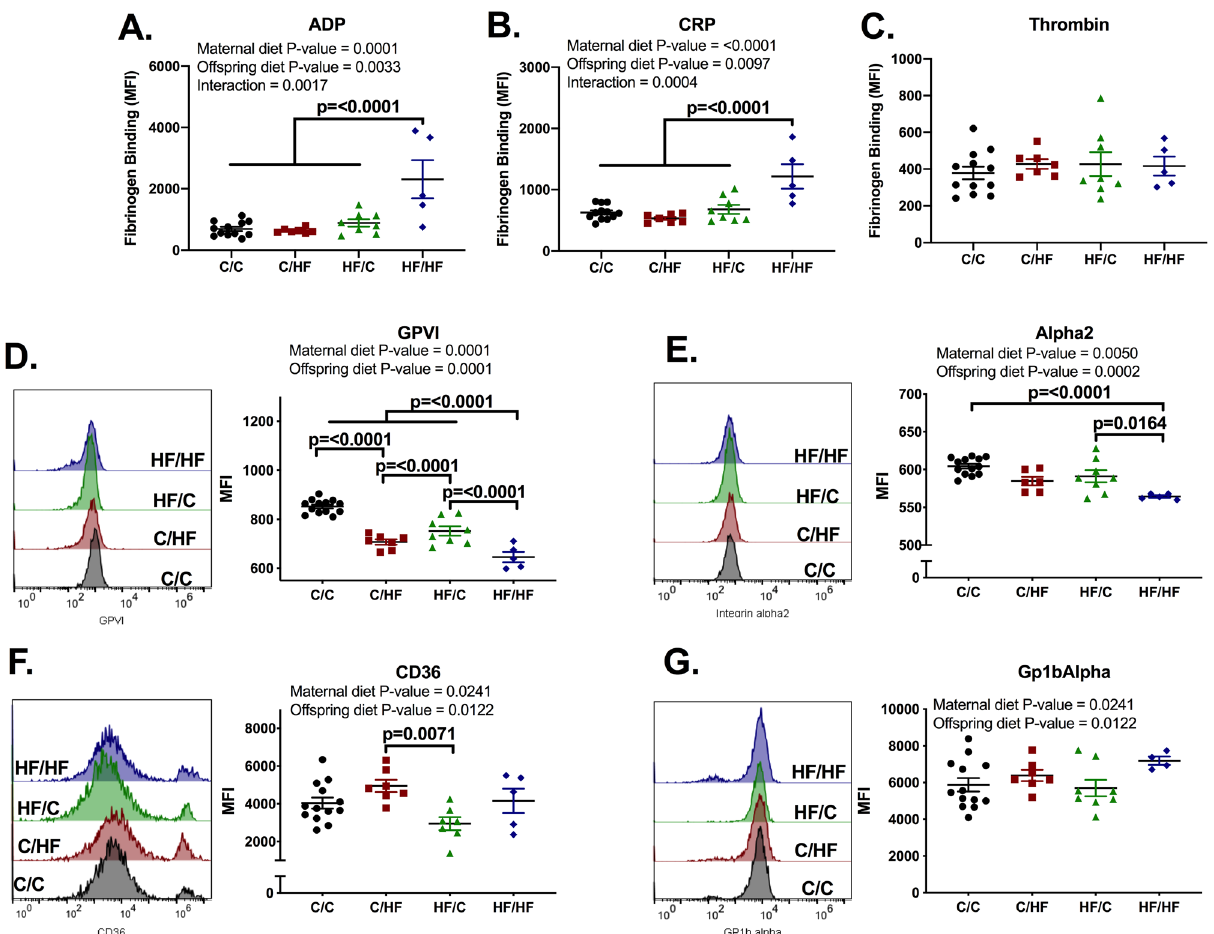
Figure 4. Maternal and offspring high-fat diet ingestion resulted in platelet hyperactivation of male offspring. Platelet-rich plasma (PRP) was stimulated with 10 μM ADP ( A ), 3 μg/mL CRP ( B ) or 0.1 U/mL Thrombin ( C ) and FITC-conjugated fibrinogen binding measured through flow cytometry. Resting PRP was incubated with antibodies for GPVI (D), α2 integrin ( E ), CD36 ( F ) and Gp1bα ( G ) receptors and measured using flow cytometry. C/C, dam and offspring fed standard laboratory diet; C/HF dam fed standard laboratory diet and offspring fed high-fat diet; HF/C dam fed high-fat diet and offspring fed standard laboratory diet; HF/HF dam and offspring fed high-fat diet. N = 5–13 mice from 4 to 6 litters per group. Graphs show mean ± SEM as well as individual values. Data analysed by two-way ANOVA with Tukey’s multiple comparisons test. P-values as well as the overall effects of maternal and offspring diet are reported where